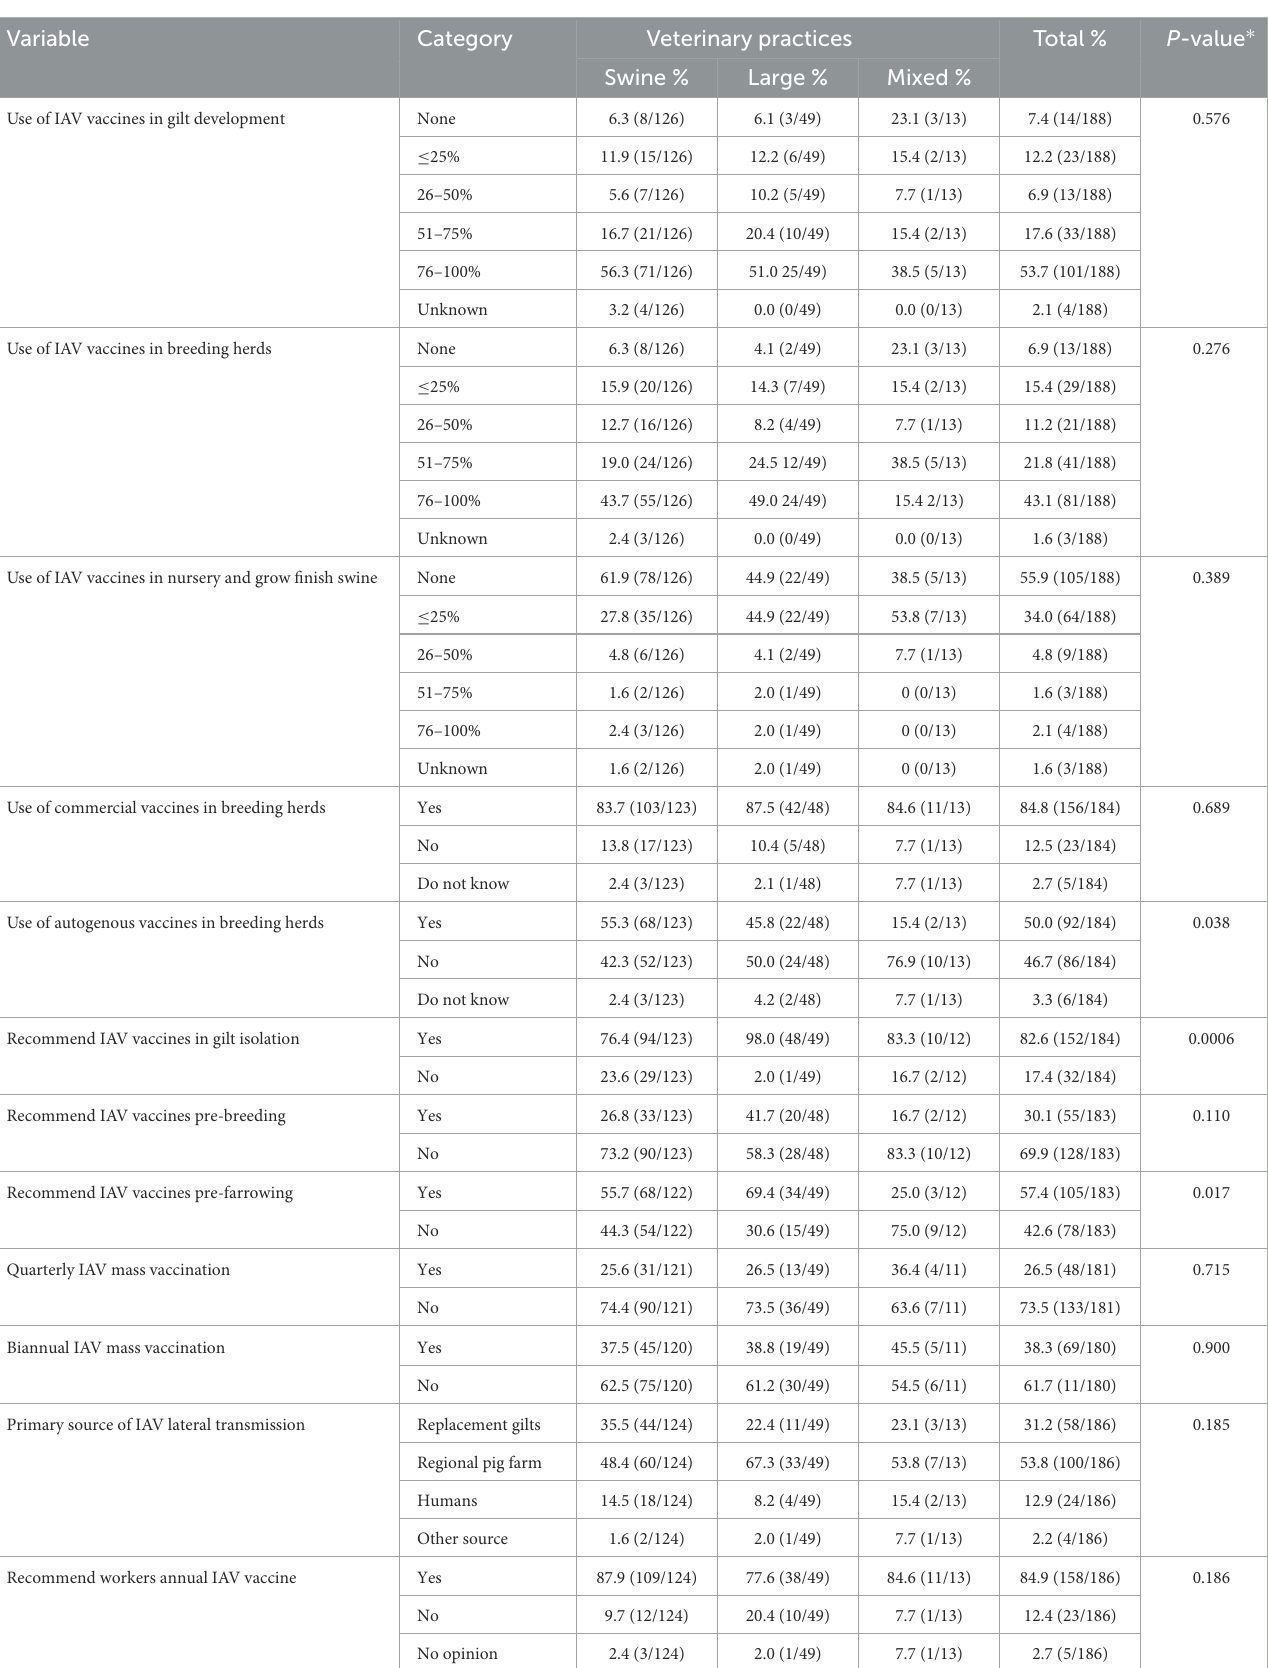
TABLE 3 Survey responses regarding the perceptions of influenza A virus reported by veterinarians in swine exclusive, large animal, or mixed animal veterinary